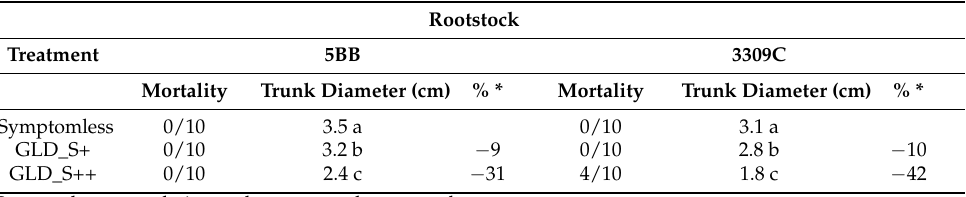
Table 2. Mortality rate (dead vines/total number of vines planted at the study’s beginning) and trunk diameter (mean) measured at the end of the experiment according to rootstock and virus infection. Means followed by different letters differ significantly at p < 0.01 by Ducan’s new multiple range test. GLD_S+: Grapevine leafroll disease causing mild symptoms; GLD_S++: grapevine leafroll disease causing severe symptoms. Means were denoted by different letters (a, b, and c) when they differ significantly at p < 0.05 using Ducan’s new multiple range